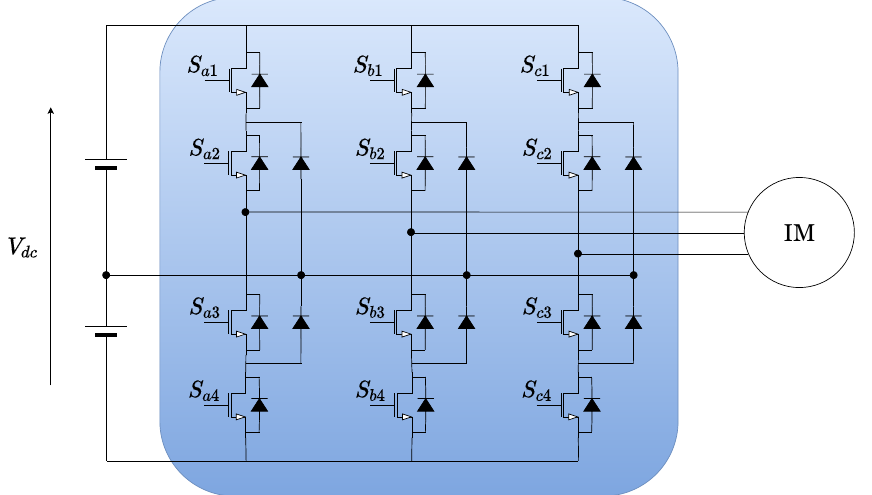
Figure 2. Simplified circuit of 3L-NPC converter supplying an